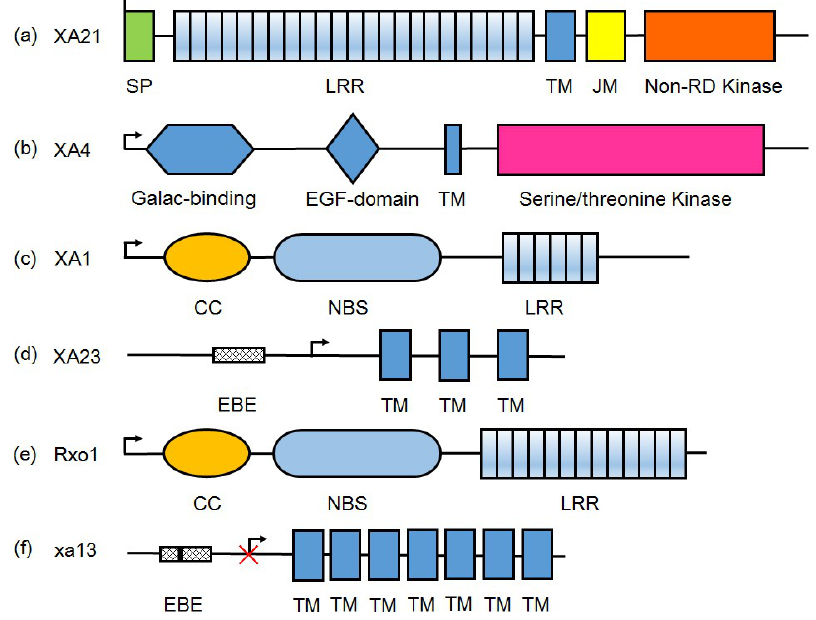
Figure 1. The protein domain structures of representative R -gene products for Xoo resistance. ( a ) Receptor kinase, including XA21 and XA3/XA26. XA21 is exampled for illustrations here; ( b ) Wall-associated kinase, XA4; ( c ) Nucleotide-binding leucine-rich repeat (NLR)-type, XA1; ( d ) Executor R proteins, including Xa10, XA23, and XA27. Xa23 is exampled; ( e ) Nonhost R protein from maize, Rxo1; ( f ) SWEET protein encoded by recessive type R genes such as xa13 , xa25 , and xa41 . These recessive type R genes are evolved by mutation (black vertical line in the EBE box) in promoter to block transcription activator-like effectors (TALE)-induced susceptibility. xa13 is exampled here. SP: signal peptide; LRR: leucine-rich repeat domain; TM: transmembrane domain; JM: juxtamembrane domain; non-RD: non-arginine-aspartate domain; Galac-binding: galacturonan-binding domain; EGF: calcium-binding epidermal growth factor domain; CC: coiled-coil domain; NBS: nucleotide binding site; EBE: effector binding element. Arrow indicates the direction of transcription.